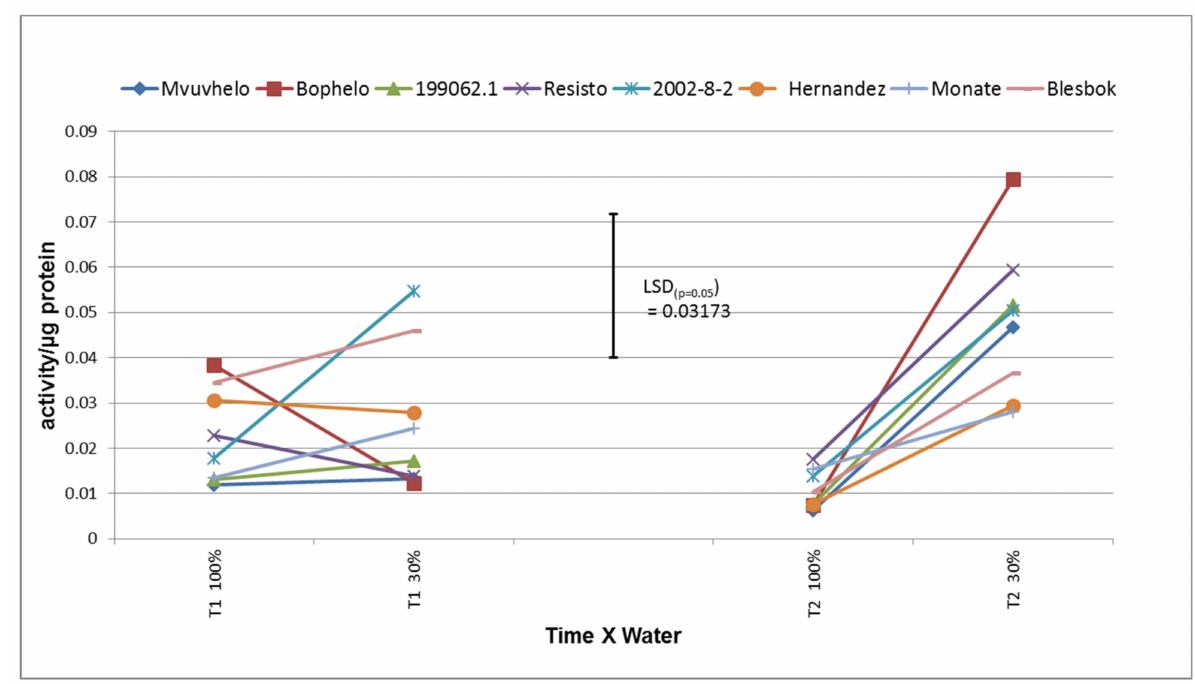
Figure 2. Ascorbate peroxidase activity (APX) of eight sweet potato cultivars in reaction to drought. LSD = 0.03173; T1 = 60 days after planting, T2 = 120 days after planting, 100% = control ( p = 0.05) treatment, 30% = severe stress